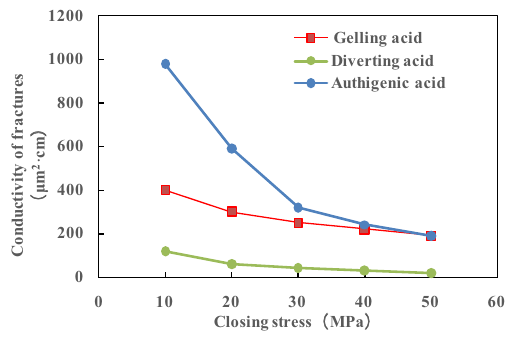
Fig. 1 Porosity distribution of Deng-4 zone reservoir in MX-E block in the platform